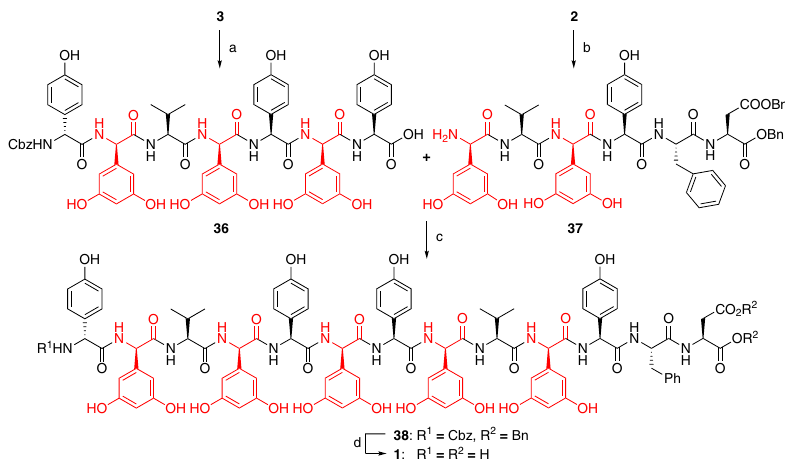
Figure 5 | Total synthesis of feglymycin (1). Conditions: ( a ) Me 3 SnOH, 1,2-dichloroethane; 85 (cid:2) C, 3.5h; ( b ) PS-Ph 3 P-Pd, PhSiH 3 , CH 2 Cl 2 /MeOH/H 2 O, r.t., 50min; ( c ) DEPBT, NaHCO 3 , DMF, 0 (cid:2) C, 24h, then 25 (cid:2) C, 11h, 2 steps 44% from heptapeptide 3 . ( d ) H 2 , Pd/C, MeOH, r.t., 3h,